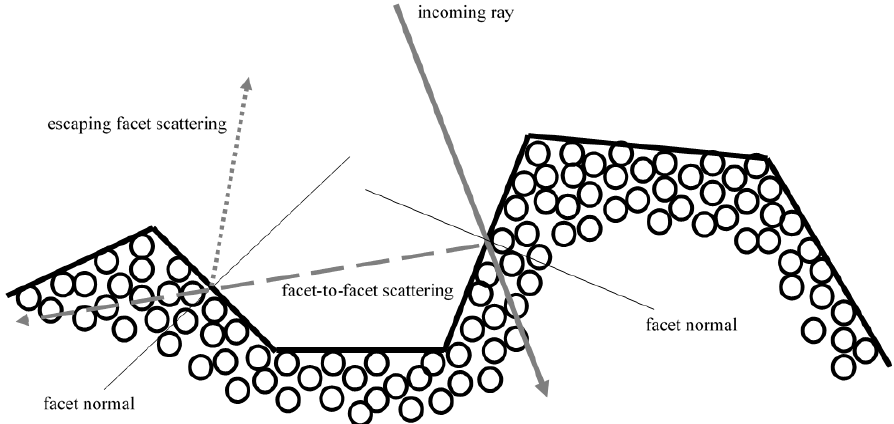
Figure 3. Facet structure of a randomly rough surface of spherical scatterers. The arrows indicate an example of a possible ray path involving facet-to-facet scattering.